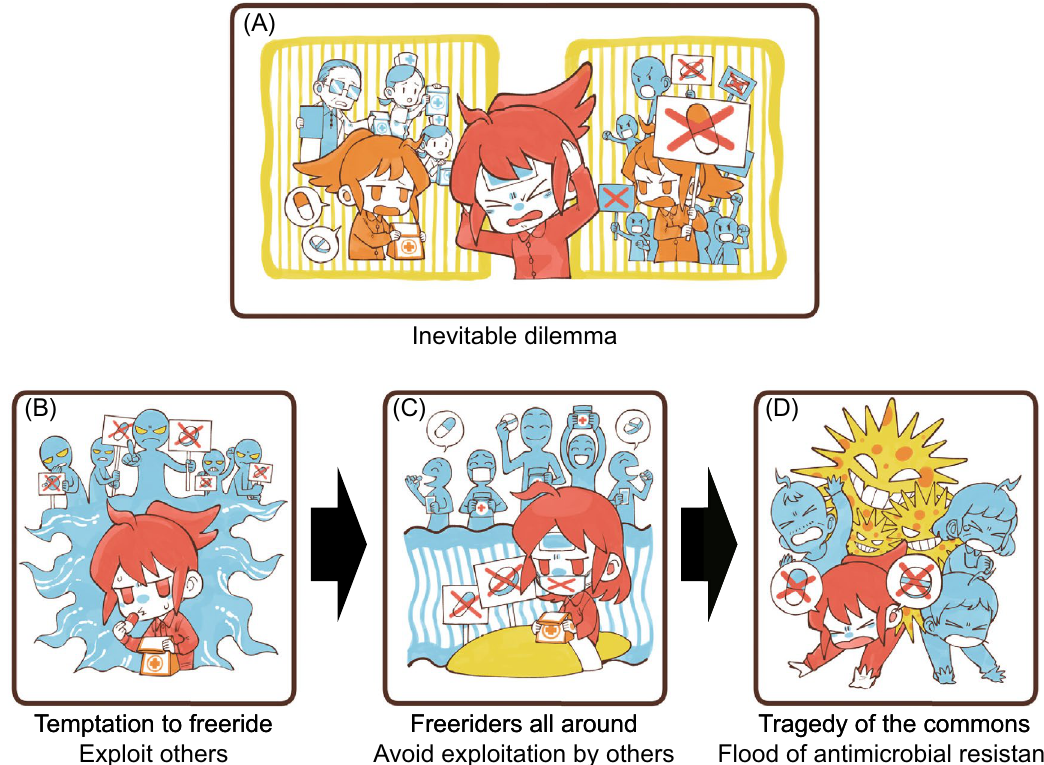
Figure 1. The social dilemma in the excess use of antimicrobials and the resulting emergence/spread of antimicrobial resistance (AMR). ( A ) If everyone tries to free ride (use antimicrobials freely), a flood of AMR is inevitable. Do you (and everybody) use antimicrobials, ignoring AMR or do you not use antimicrobials unless necessary, to avoid AMR? ( B ) If you free ride on the cooperative behavior of others, only you will receive benefit from the antimicrobials. People have a common understanding (public stance) to refrain from free use of antimicrobials. However, they will also be tempted to use antimicrobials themselves secretly. The rational choice is to free ride (use antimicrobials), increasing the risk of AMR. Do you? ( C ) As more people use antimicrobials unnecessarily, the incentive for cooperators (you) to refrain from using antimicrobials decreases. The rational choice is to use antimicrobials (free ride) because everybody uses the drugs. Do you? ( D ) The tragedy of the commons appears: the risk of AMR flooding is increasing. A flood of AMR is an undesirable outcome for free riders. Here, effective antimicrobials are common and can be exploited by free